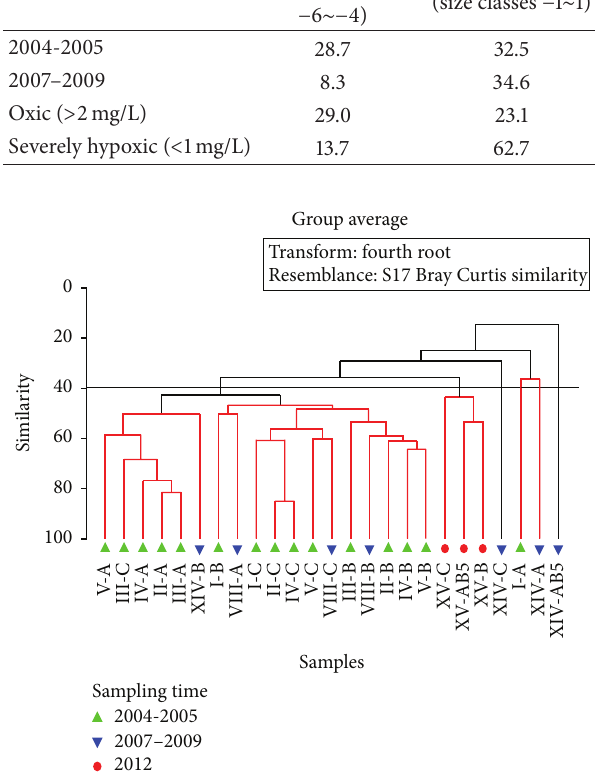
Figure 6: Cluster dendrogram with SIMPROF test of all sites sampled from 2004 to 2012. Cruise numbers and site names are shown under each colored symbol (“I-A” means site A in cruise I). Green: 2004-2005, blue: 2007–2009, and red dots: 2012. Red lines mean there was no reliable statistical difference ( 𝑝 > 0.05 ) between the relationships, while black lines indicate significant clusters ( 𝑝 < 0.05 ). At the 40% similarity level, the samples clustered into 5 groups. See Table 1 for sampling months of cruises I through XIV.